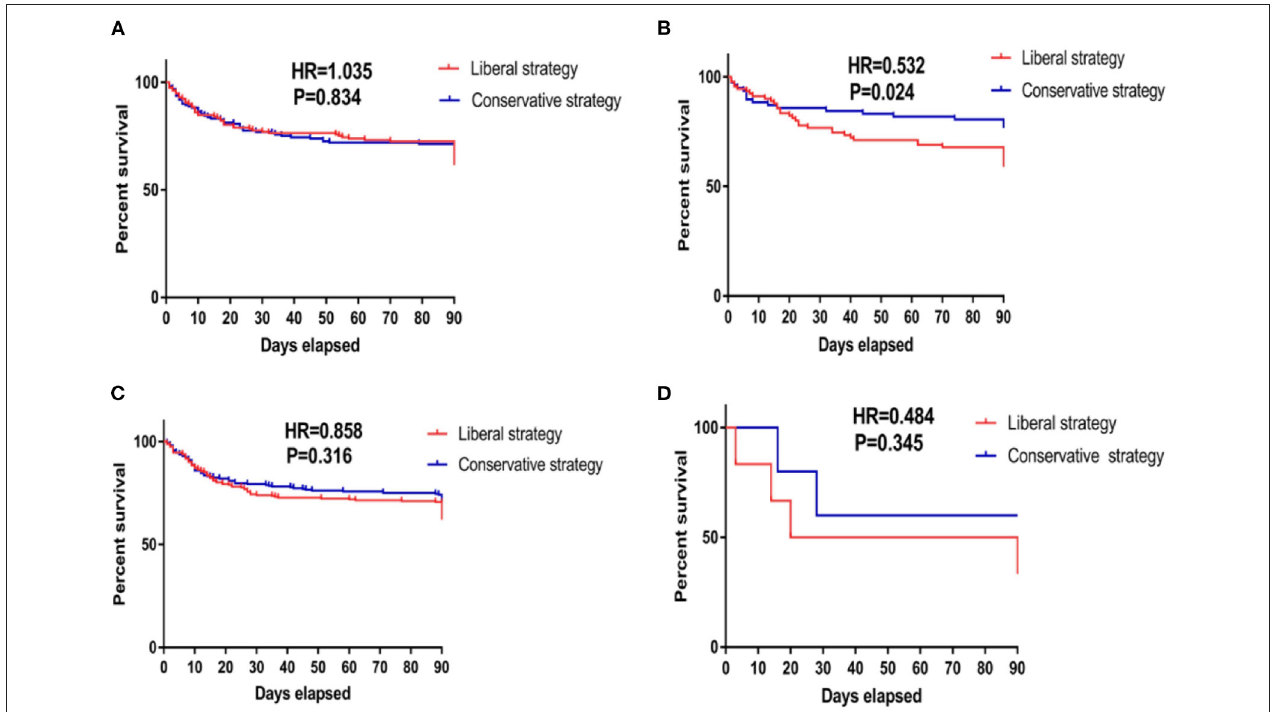
FIGURE 2 | Kaplan–Meier survival curves of 90-day cumulative mortality for patients receiving conservative strategy and liberal strategy among those with the four phenotypes. (A) The survival curves of 90-day cumulative mortality of patients classified as phenotype I. The Kaplan–Meier survival analysis indicated that compared with the liberal strategy, conservative fluid management could not improve the 90-day mortality in patients classified as phenotype I (HR = 1.035, P = 0.843). (B) The survival curves of 90-day cumulative mortality of patients classified as phenotype II. The Kaplan–Meier survival analysis indicated that compared with the liberal strategy, conservative fluid management significantly improved 90-day mortality in patients classified as phenotype II (HR = 0.532, P = 0.024). (C) The survival curves of 90-day cumulative mortality of patients classified as phenotype III. The Kaplan–Meier survival analysis indicated that compared with the liberal strategy, conservative fluid management could not improve the 90-day mortality in patients classified as phenotype III (HR = 0.858, P = 0.316). (D) The survival curves of 90-day cumulative mortality of patients classified as phenotype IV. The Kaplan–Meier survival analysis indicated that compared with the liberal strategy, conservative fluid management could not improve the 90-day mortality in patients classified as phenotype IV (HR = 0.484, P = 0.345). HR, hazard